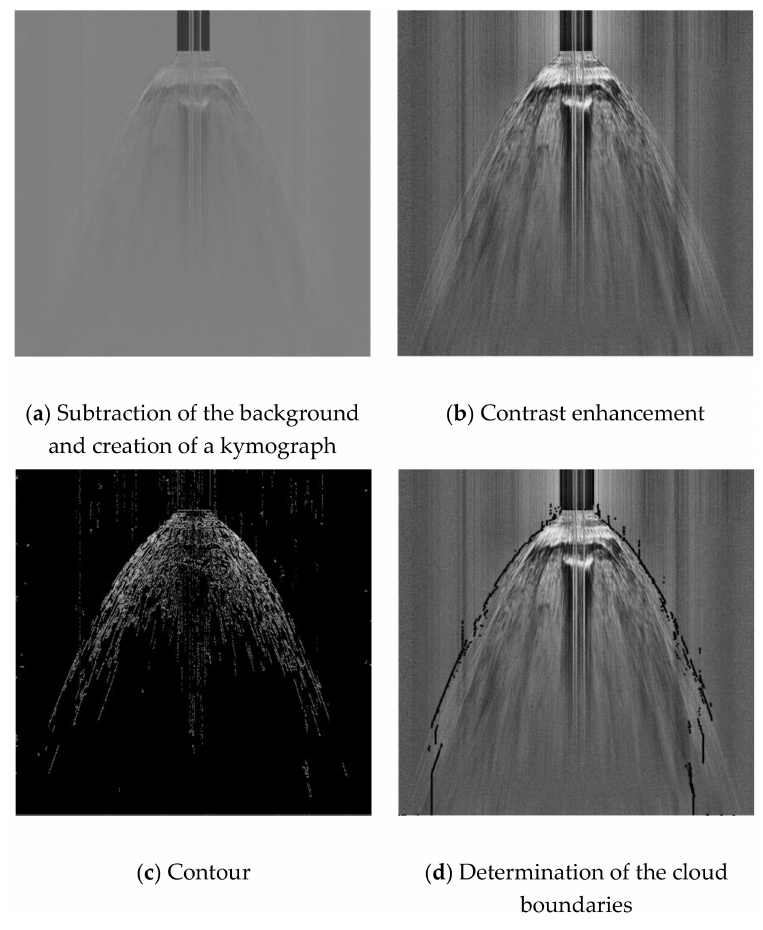
Figure 5. Processing steps for the front-view